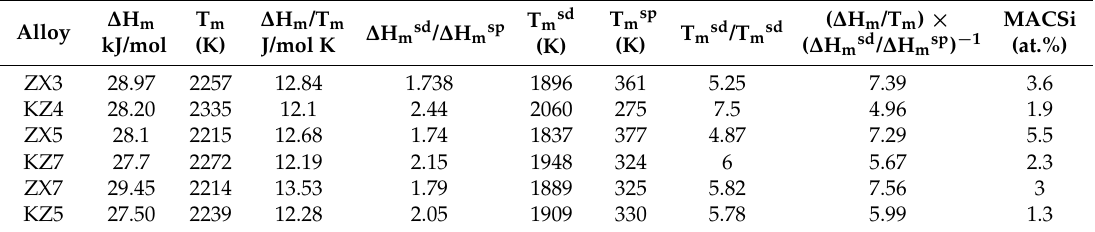
Table 5. Alloy parameters of the macrosegregation of Si in the cast alloys of this study and in the reference alloys KZ4, KZ5 and